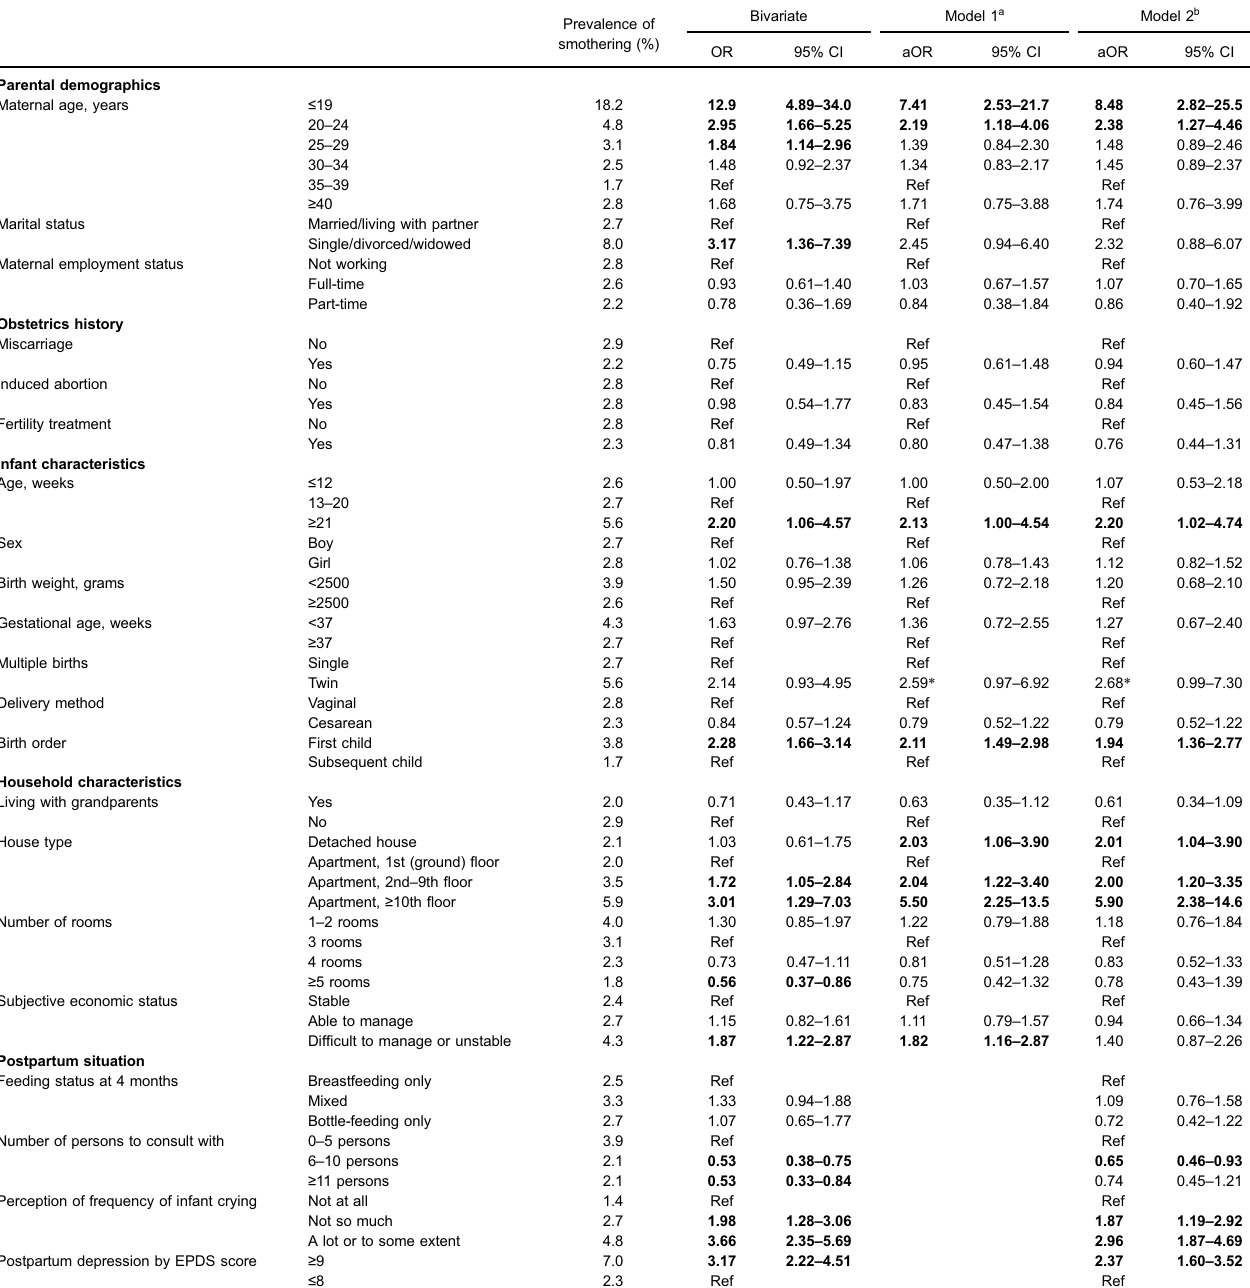
Table 4. Odds ratios of parental demographics, obstetrics history, infant characteristics, household characteristics, and postpartum situation for smothering at 4 months of